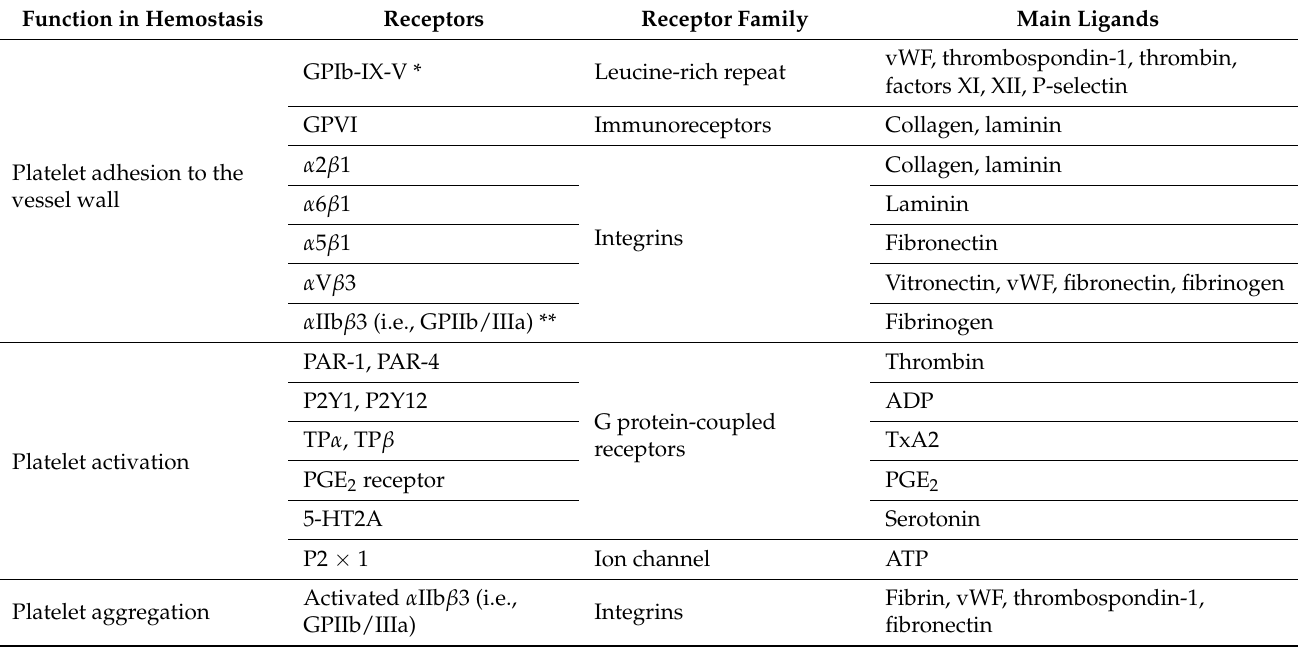
Table 2. Platelet receptors critical for the hemostatic